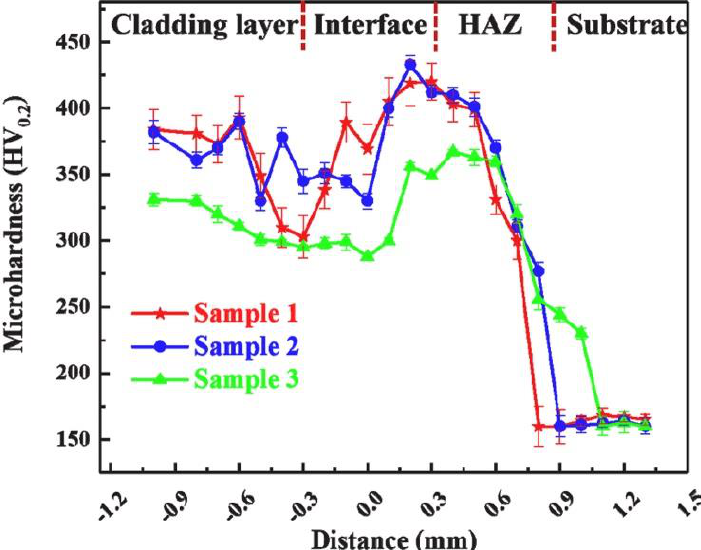
Figure 4. Variation in microhardness values of LC of 17-4 PH stainless steel on different E355DD steel specimens in the clad layer, interface, HAZ and substrate. Reproduced with permission from [23]. Copyright Elsevier, 2022.